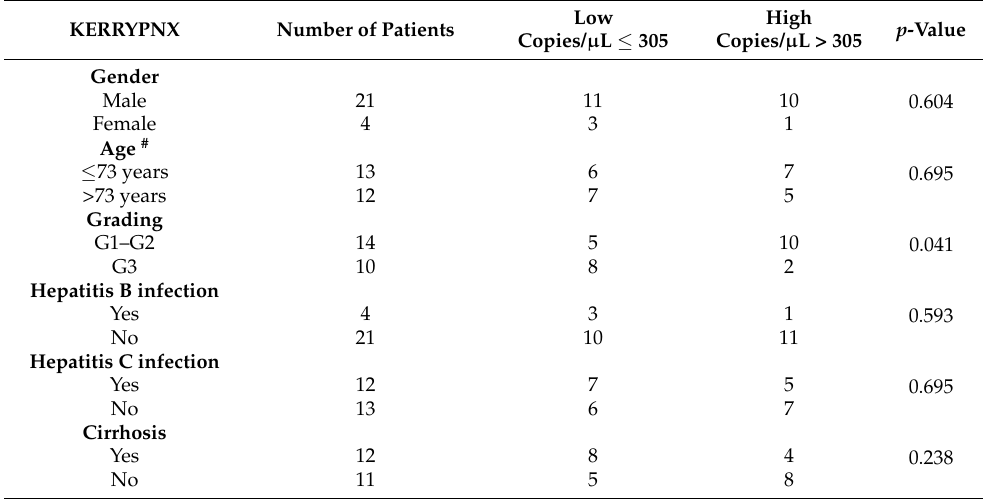
Figure 3. ddPCR determination of plasma levels of miR-23b-3p in HCC patients. ( A ) The graph shows the amount of miR-23b-3p detected in the plasma of healthy individuals (C) and HCC patients. The Mann–Whitney U-test was used to compare the two groups; * indicates a p -value < 0.05. ( B ) ROC curve analysis of miR-23b-3p in HCC patients and healthy individuals. AUC = Area Under the Curve; CI = Confidence Interval. Table 1. Associations between the clinicopathological characteristics of HCC patients and the plasmatic levels of miR-23b-3p $